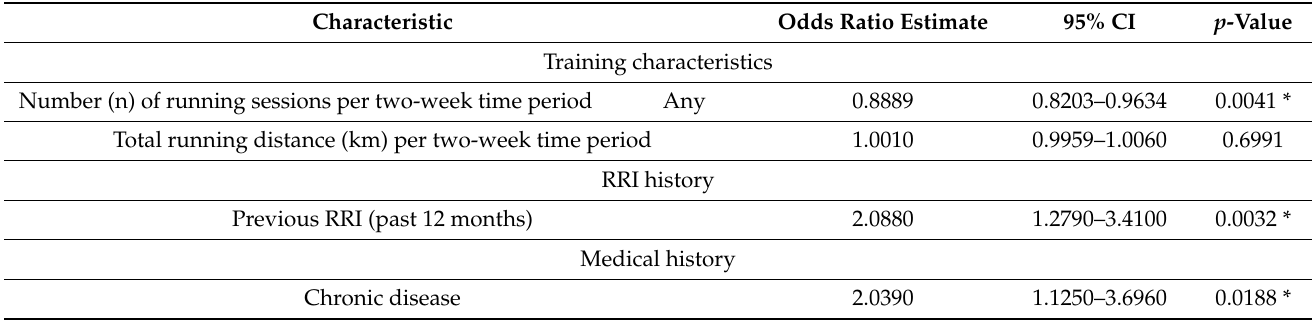
Table 6. Independent risk factors associated with RRIs among trail runners (multiple regression